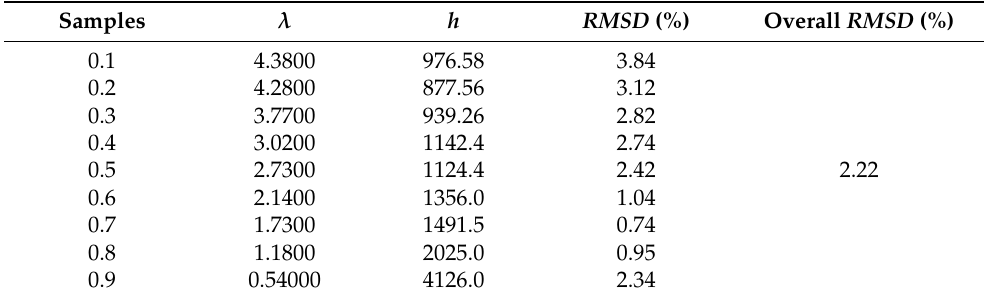
Table 9. The results of the Buchowski–Ksiazczak λ h model for TRV in various PG + water composi- tions.